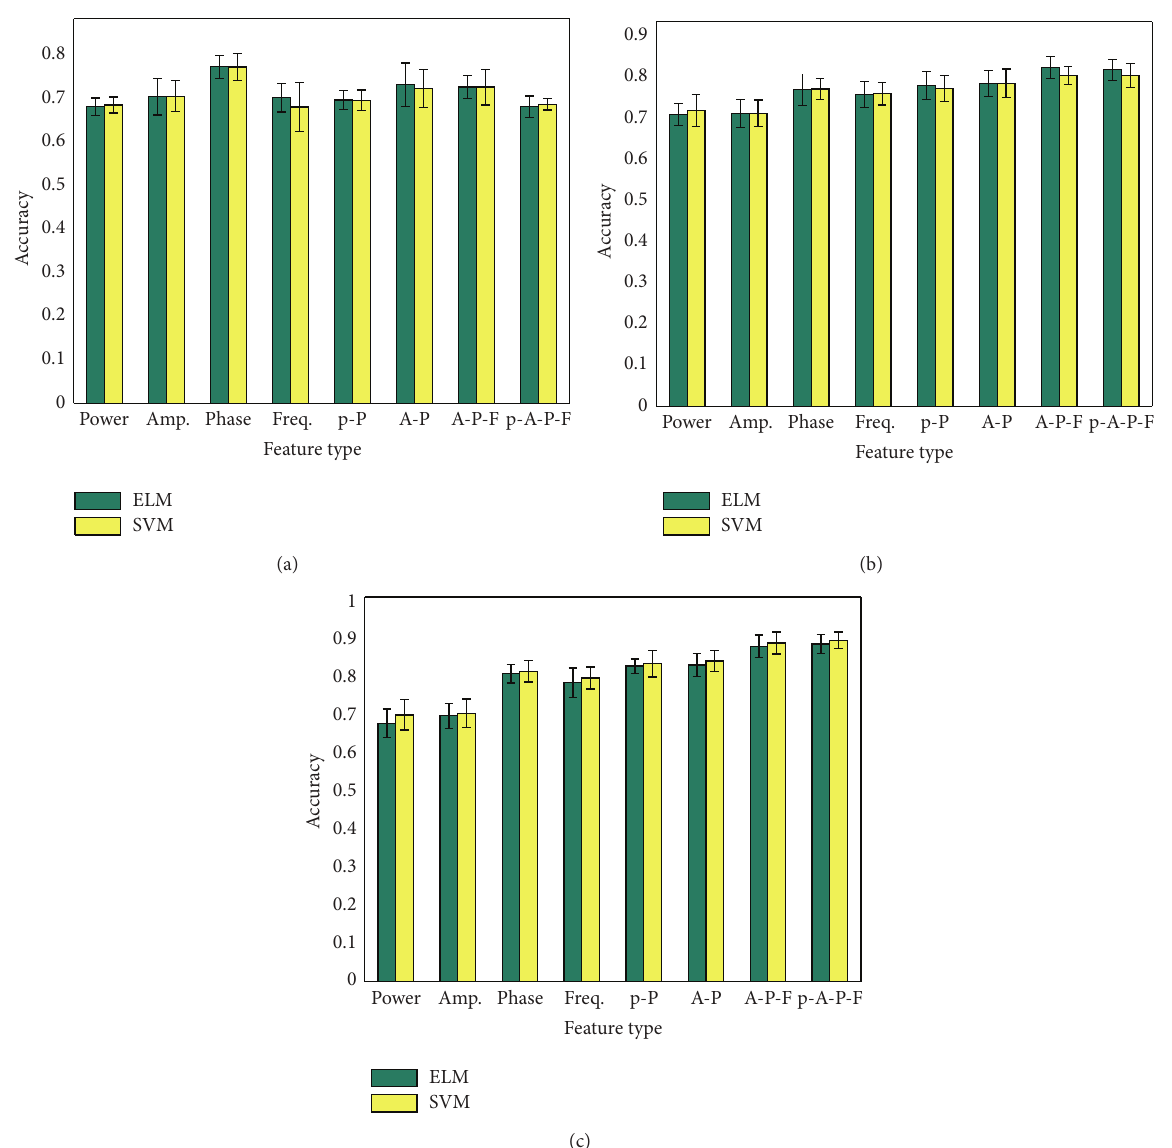
Figure 5: Comparison between the classification results between ELMs and SVMs. (a) Using the original feature and MIFS feature selection criterion. (b) Using the scaled feature and MIFS feature selection criterion. (c) Using the scaled feature and mRMR feature selection